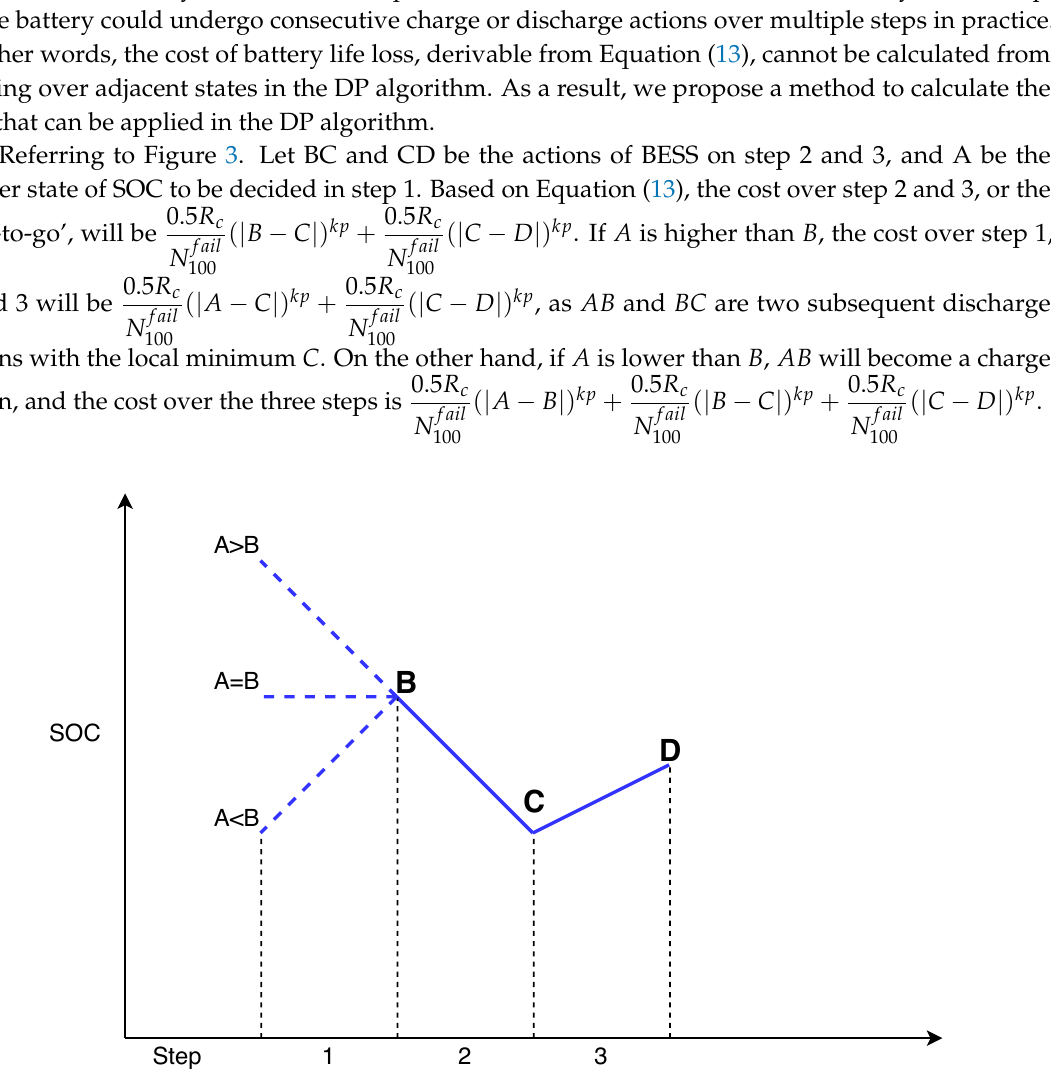
Figure 3. State of charge (SOC) profile used for